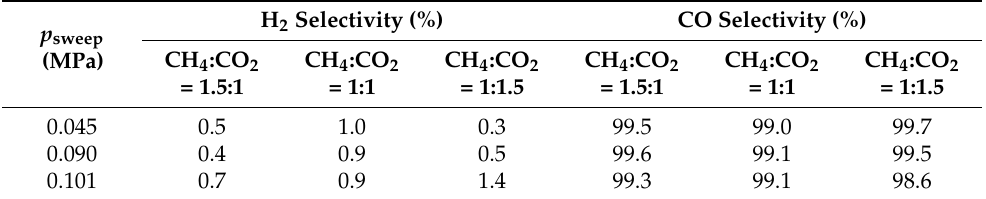
Table 6. Relationship between H 2 , CO selectivity and p sweep changing molar ratios of CH 4 :CO 2 .